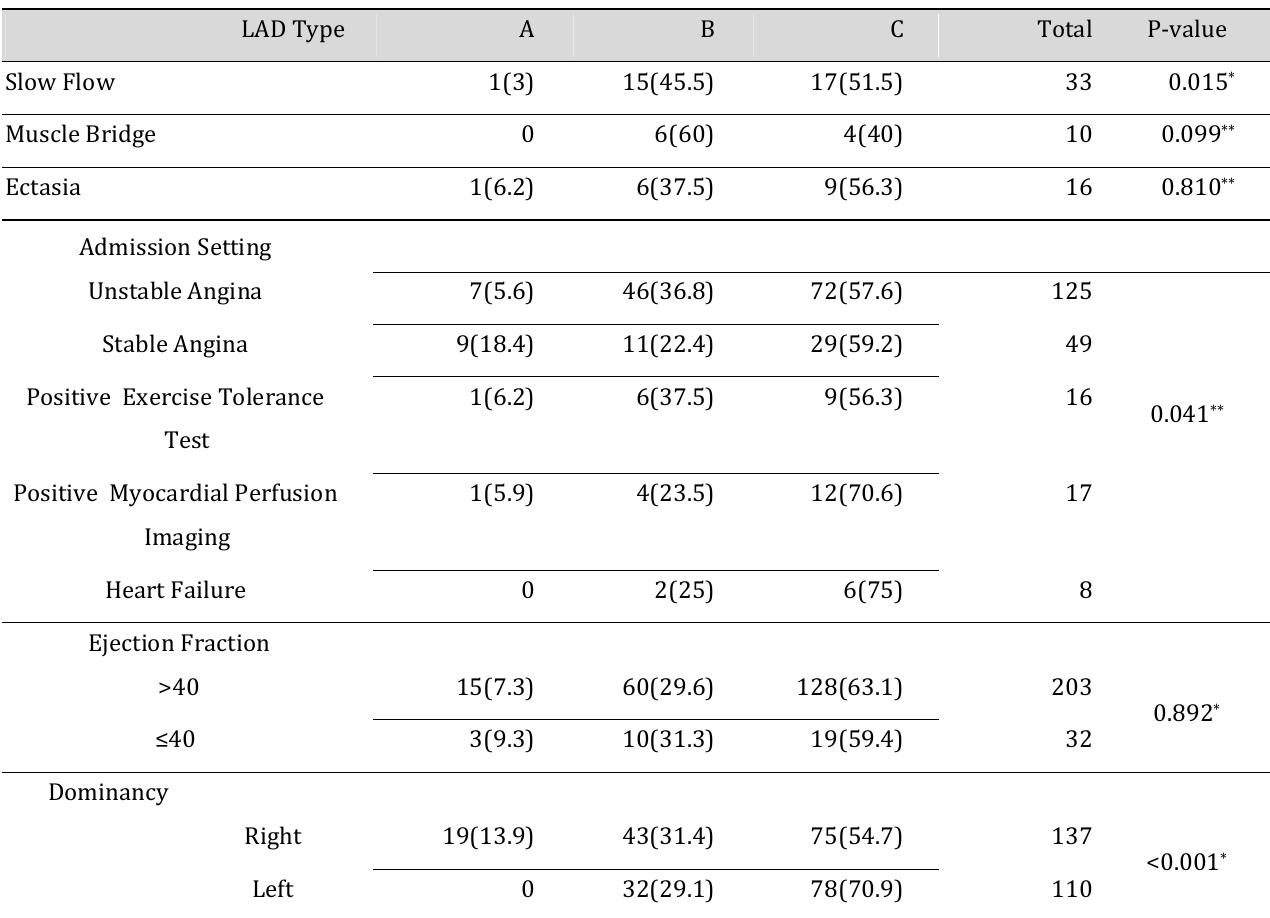
LAD, Left Anterior Descending; VHD, Valvular Heart